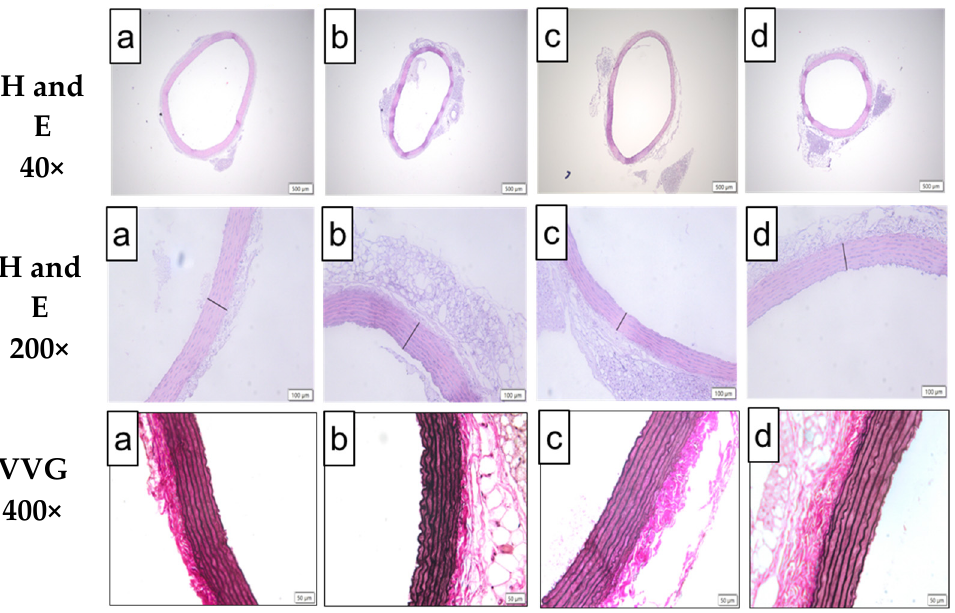
Figure 4. Representative photographs of aortic arch sections stained with H&E (magnification = 40× and 200×, scale bar = 500 µm and 100 µm) and VVG (magnification 400×, scale bar = 50µm) from ( a ) normal, ( b ) OB, ( c ) OB/BB and ( d ) OB/OR groups. H&E staining showed the presence of normal aorta lining in the normal group, while a thicker aorta was observed in the OB group compared to the normal group. The thickness of the aorta was also markedly reduced in OB/BB and OB/OR groups compared to the OB group. VVG staining showed the presence of wavy, irregular and tortuous elastic lamella in the OB group and the internal lamella lining was homogenously improved in ( c ) and ( d ) groups compared to ( b ) OB: obese, OB/BB: obese, and bee bread 0.5 g/kg/day, OB/OR: obese and orlistat 10 mg/kg/day, H&E: hematoxylin and eosin, VVG: Van Verhoef Gielson.